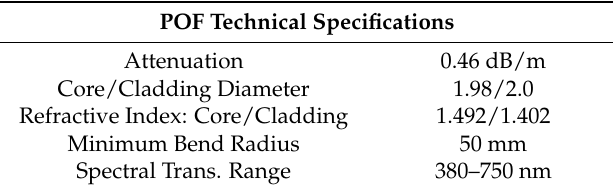
Table 1. Plastic optical fiber (POF) parameters for design and simulation.